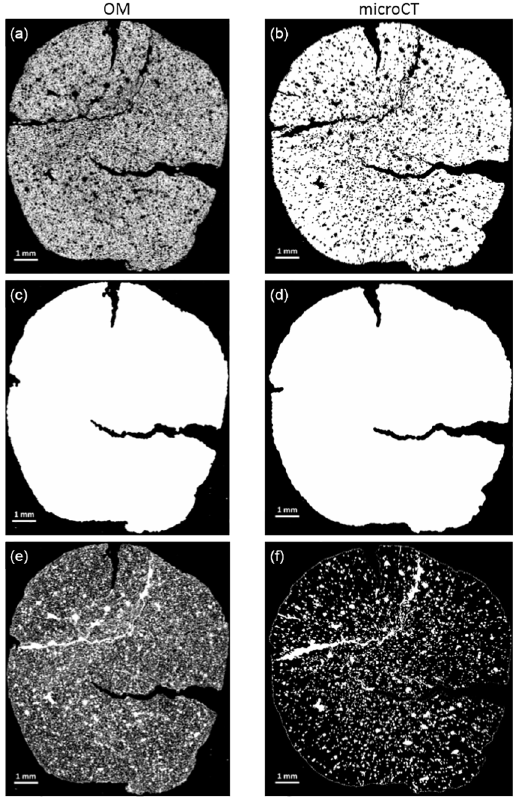
Figure 14. Processed images: (a) Segmentation-OM; (b) Segmentation- microCT; (c) ROI-OM; (d) ROI-microCT; (e) Pores-OM; (f) Pores-microCT.